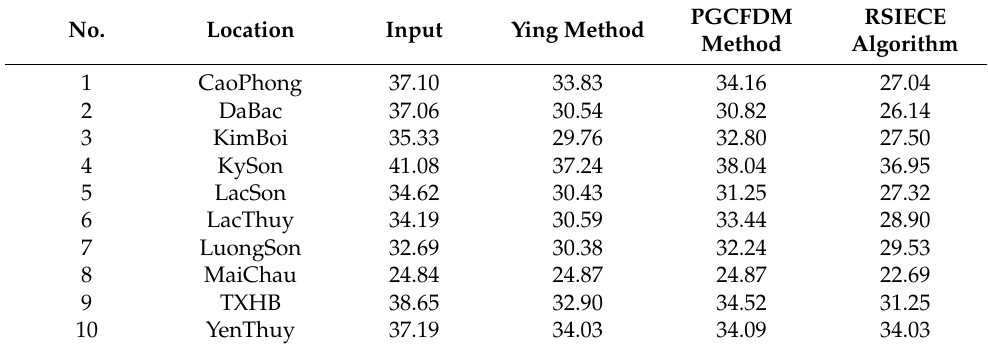
Table 5. IL-NIQE index of enhanced images by the RSIECE algorithm compared to the Ying and PGCFDM